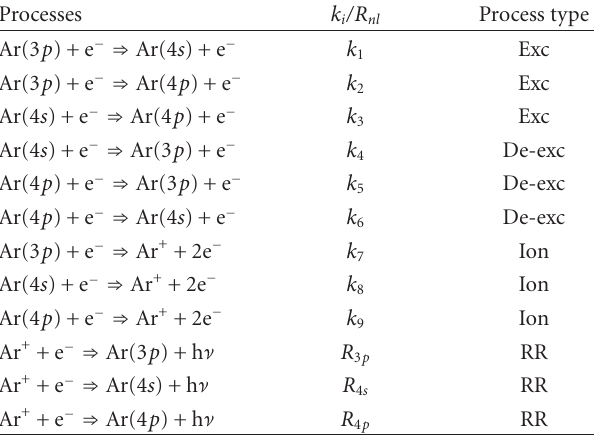
and Ar(4 p ), with rates of the order of − 10 10 cm − 3 s − 1 and − 10 5 cm − 3 s − 1 have been neglected.